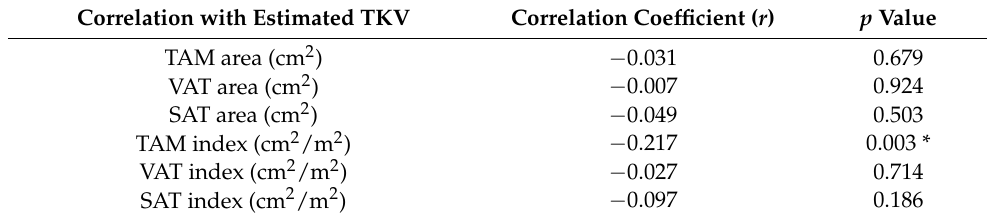
Table 2. Correlation between body composition analysis and total kidney